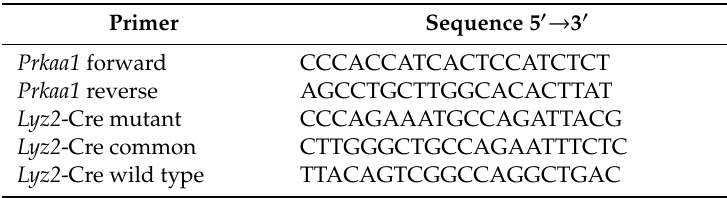
Table 1. Primer sequences used for genotyping. Primer Sequence 5 (cid:48) → 3 (cid:48) Prkaa1